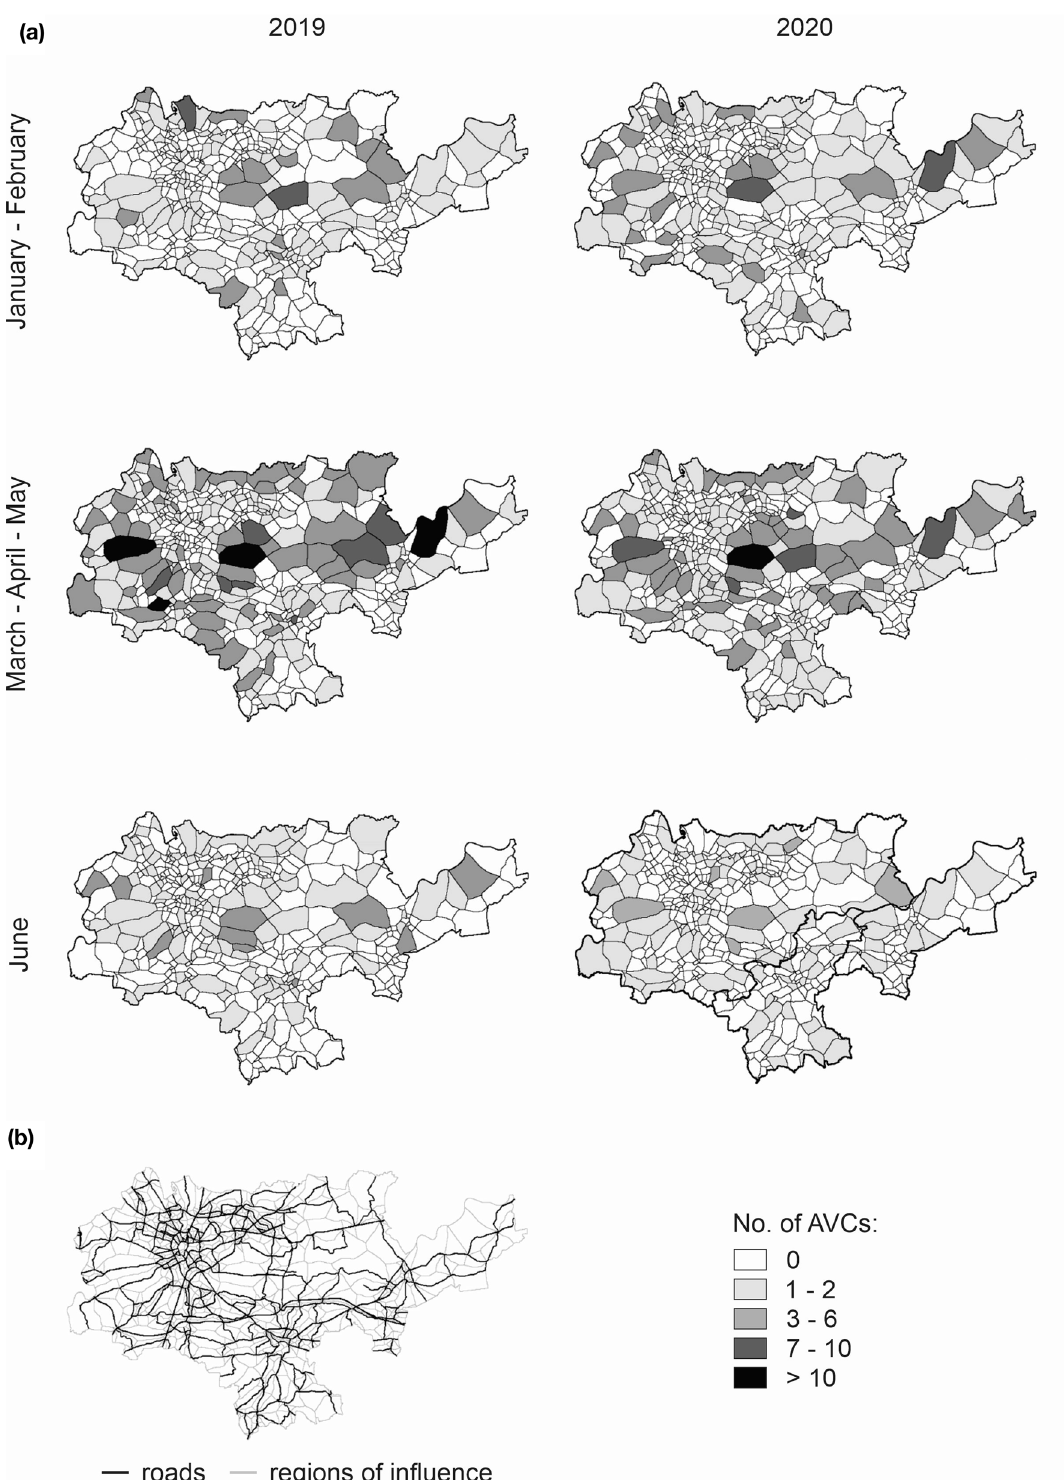
Figure 5. Spatial pattern change of AVC ( a ) Number of AVC incidents reported in regions of influence defined by the network of main streets. ( b ) The network of main streets in the studied communes of Krakow, Wieliczka and